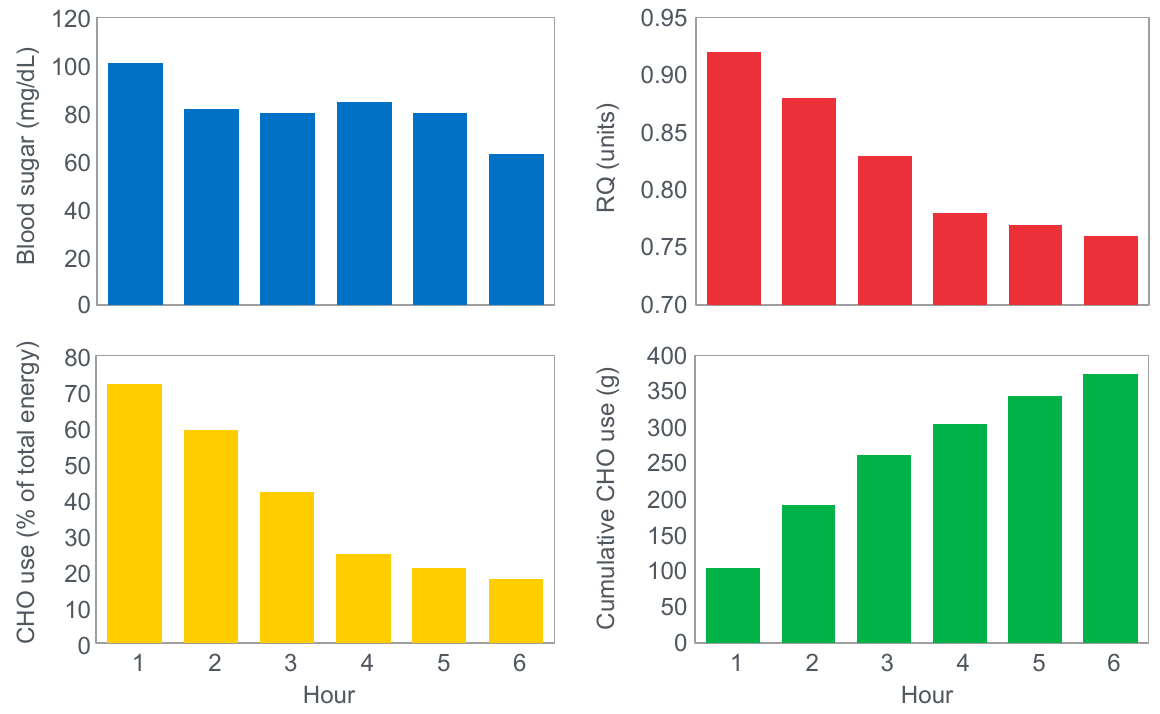
Figure 1. Changes in metabolic variables during 6 h of exercise in Runner Y. Reproduced from data in [12].